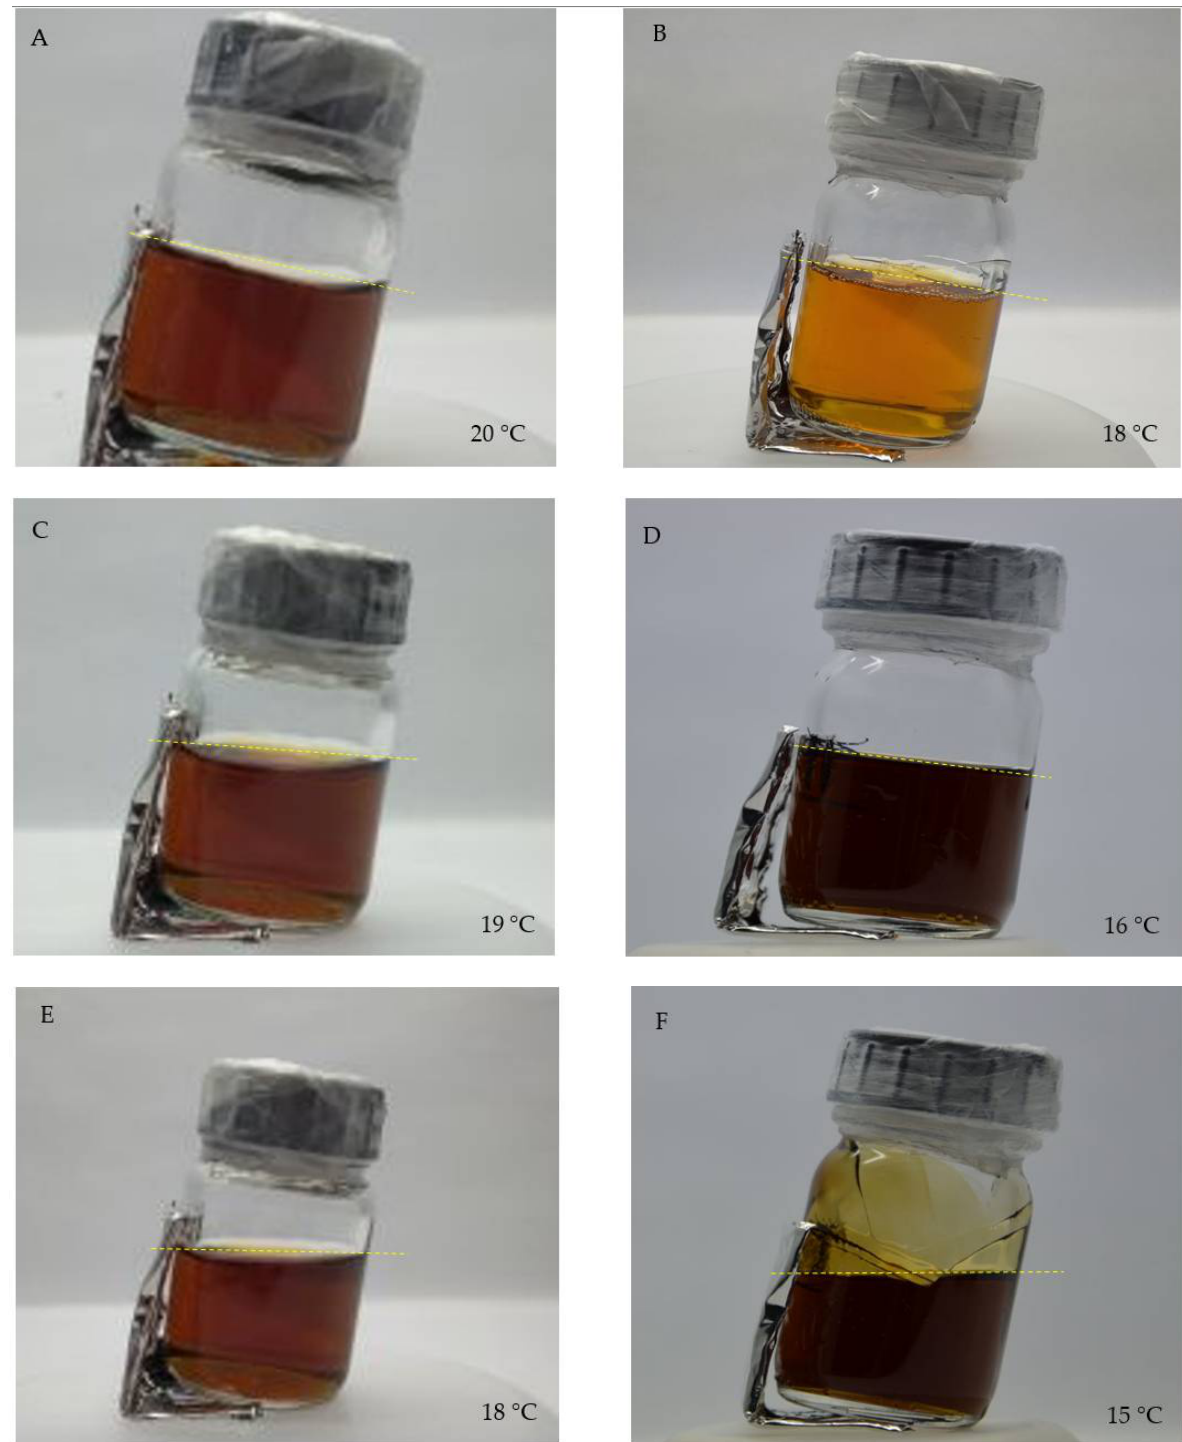
Figure 1. Photographs of non-irradiated Fricke-XO-Pluronic F-127 without ( A , C , E ) and with 0.2 M NaCl ( B , D , F ) during Test 1 observations. The temperatures of the gels are indicated in the pho- tographs. The colour change of the dosimeter occurred after 5 days of experiment. The initial colour of the dosimeter is light yellow-brown as observed in ( B ). The yellow dashed lines are to indicate the surface of the dosimeter at different